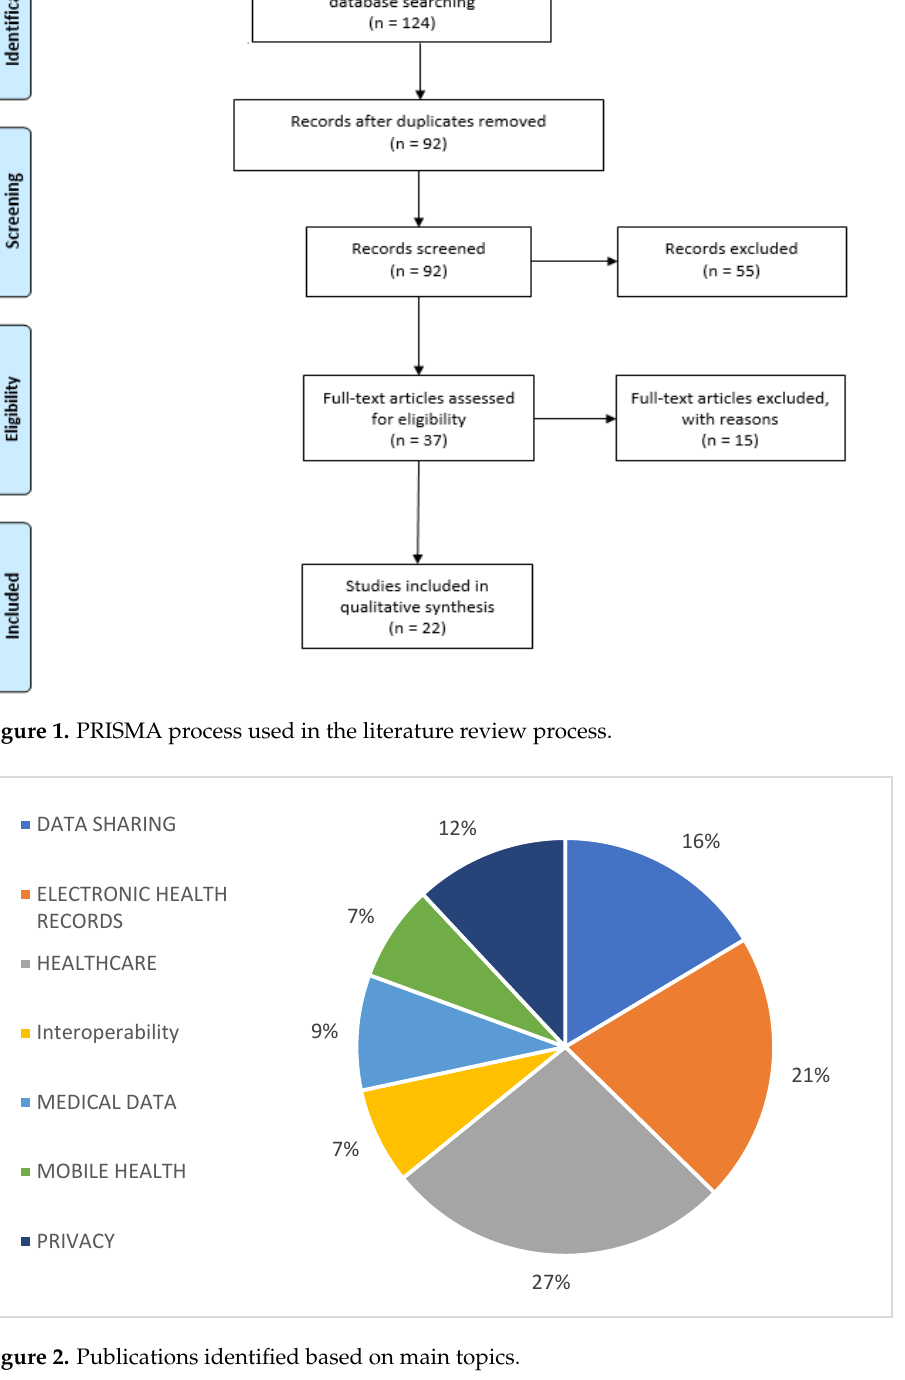
Figure 2. Publications identified based on main topics .